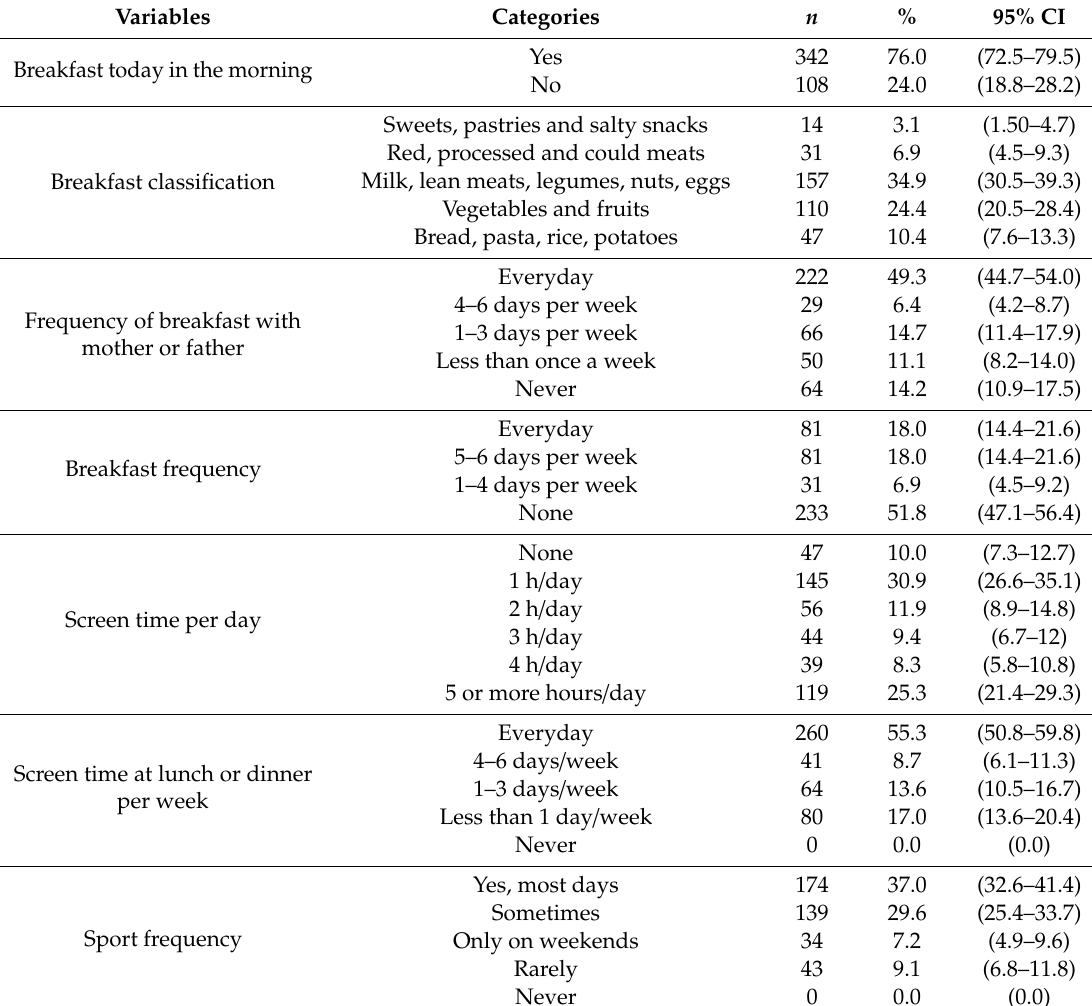
Table 2. Habits of the